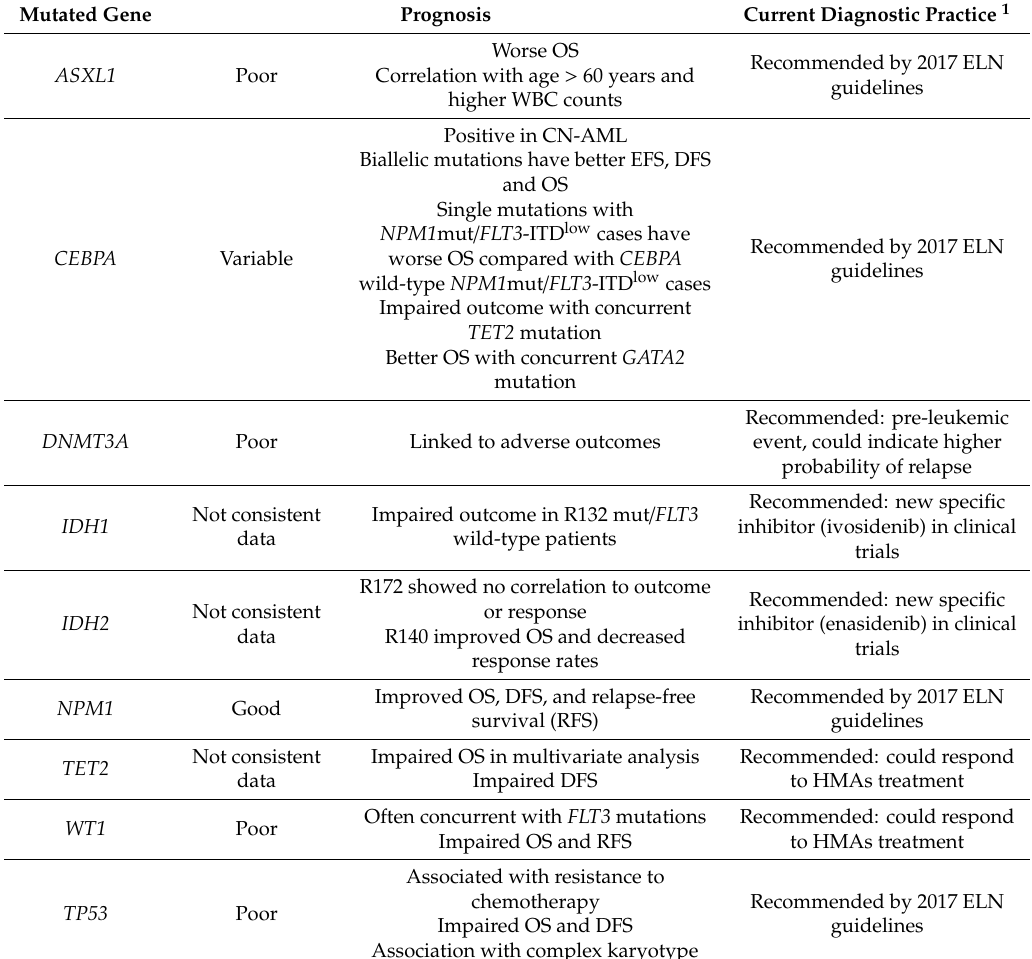
Table4. Summaryoftheimpactoftumorsuppressorgenesmutationonprognosisandrecommendations for clinical